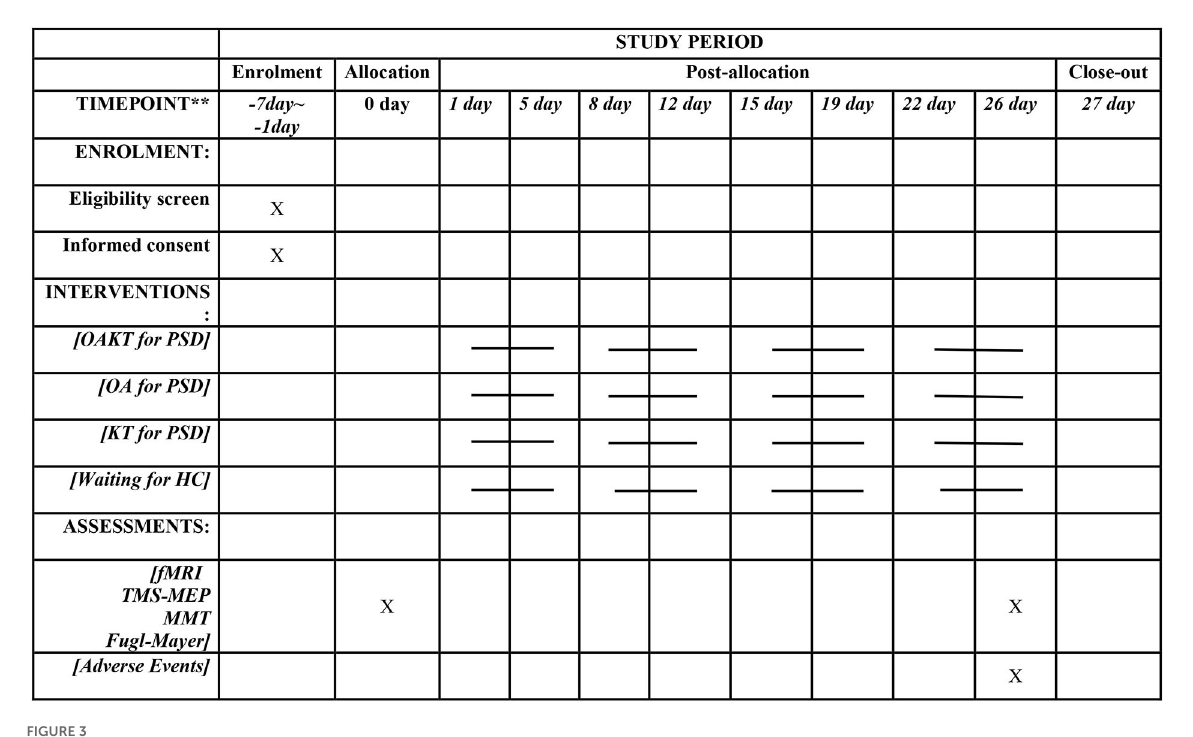
FIGURE3 Time schematic diagram of enrolment, interventions, and